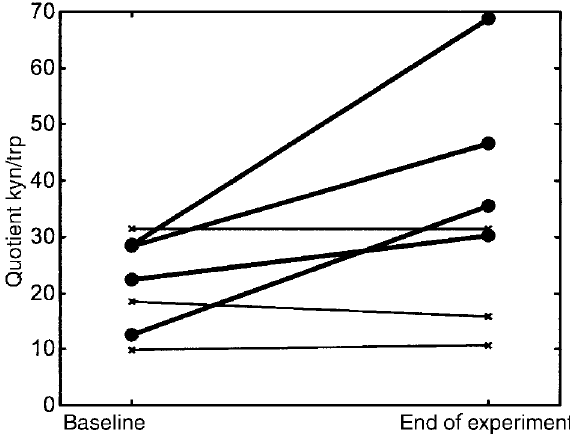
FIG. 2. Kynurenine-per-tryptophan (kyn/trp) quotients meas- ured in serum for baseline and at the end of the reanimation experiment (male (x) and female (o)